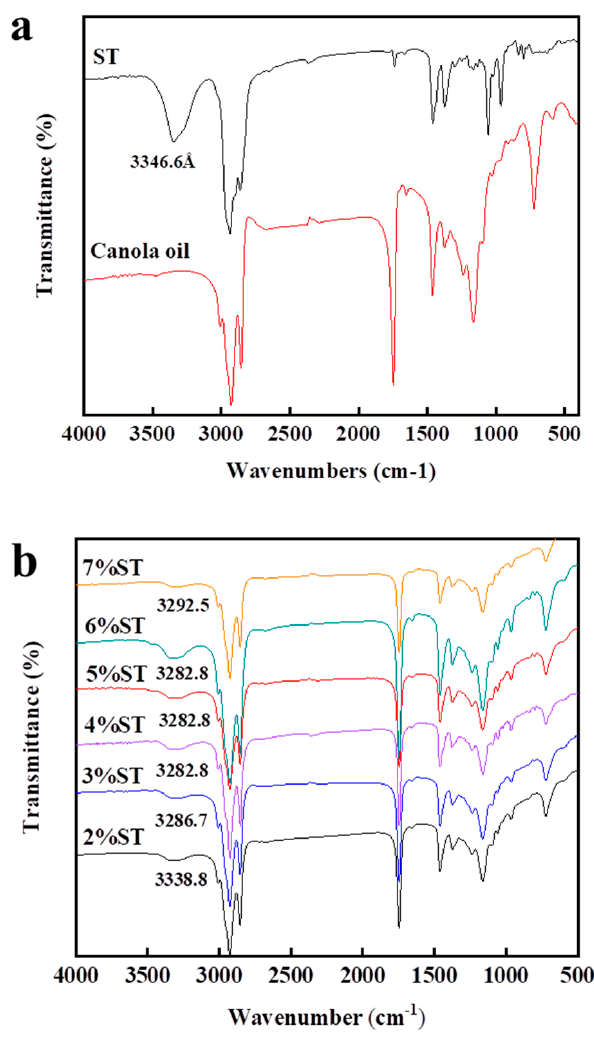
Figure 9. The FT-IR of rapeseed oil and stigmasterol ( a ); organogels with diverse stigmasterol concentrations ( b ).